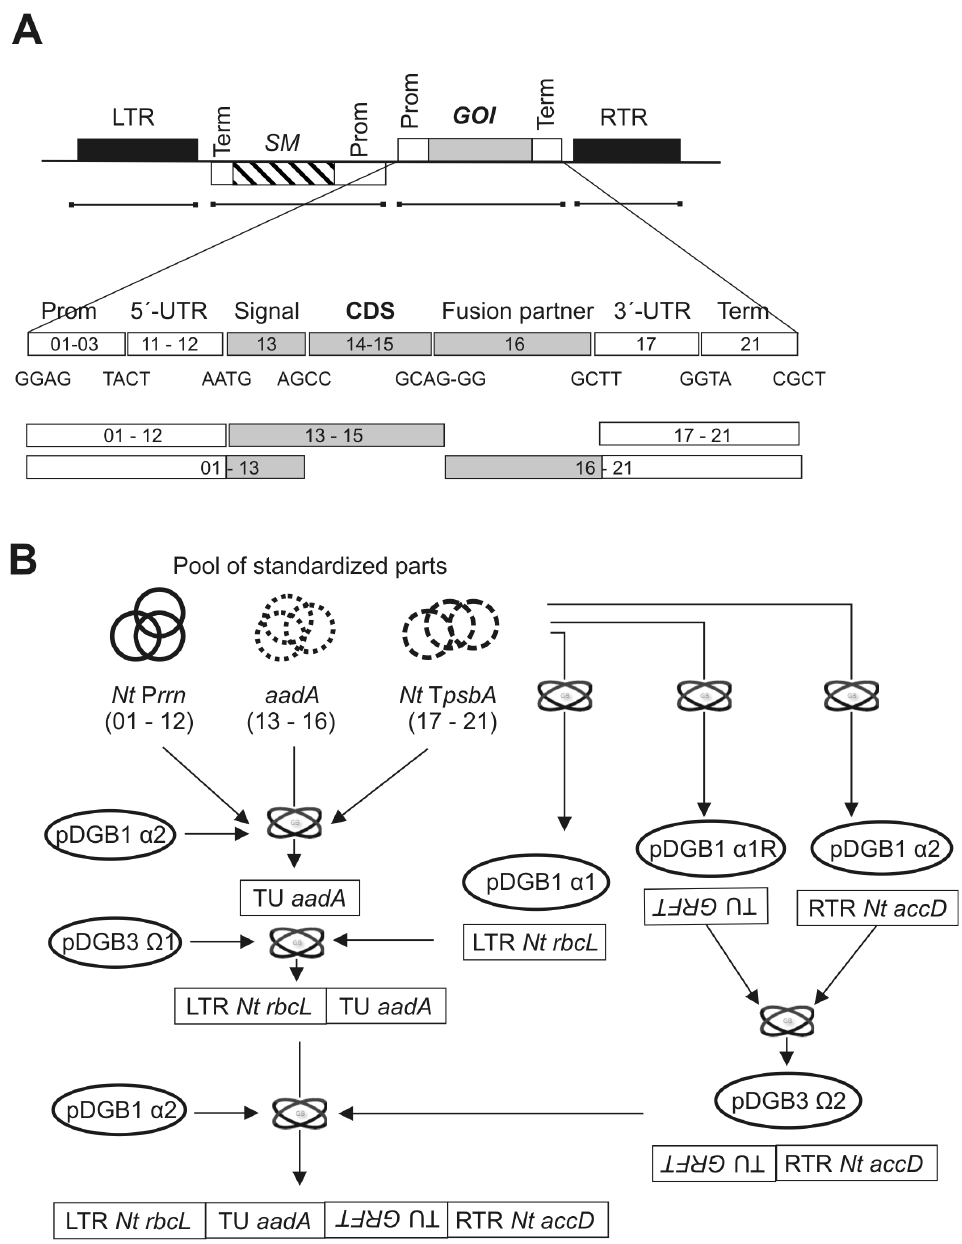
Figure 1. Schematic representation of the modular build-up and the overall GB-based cloning strategy of expression vectors. A) Generic structure of a plastid transformation vector. Magnified details show the modular build-up of a transcriptional unit and how it can be assembled from a set of standardized parts. Numbers within the boxes represent part identity and compatibility. Prom, promoter; Term, terminator; LTR, left targeting region; RTR, right targeting region; UTR, untranslated region; SM, selection marker; GOI, gene of interest; CDS, coding sequence. B) Schematic representation of the cloning strategy yielding the expression vector used in this study. In the pool of standardized parts, circles represent pUPD vectors harboring genetic elements (parts). Elliptical structures represent the different a - and V -vectors. Two intertwined ellipses on an arrow represent a one-pot restriction/ligation reaction (GB reaction) combining all the relevant parts. Boxes represent the parts and their assembly.